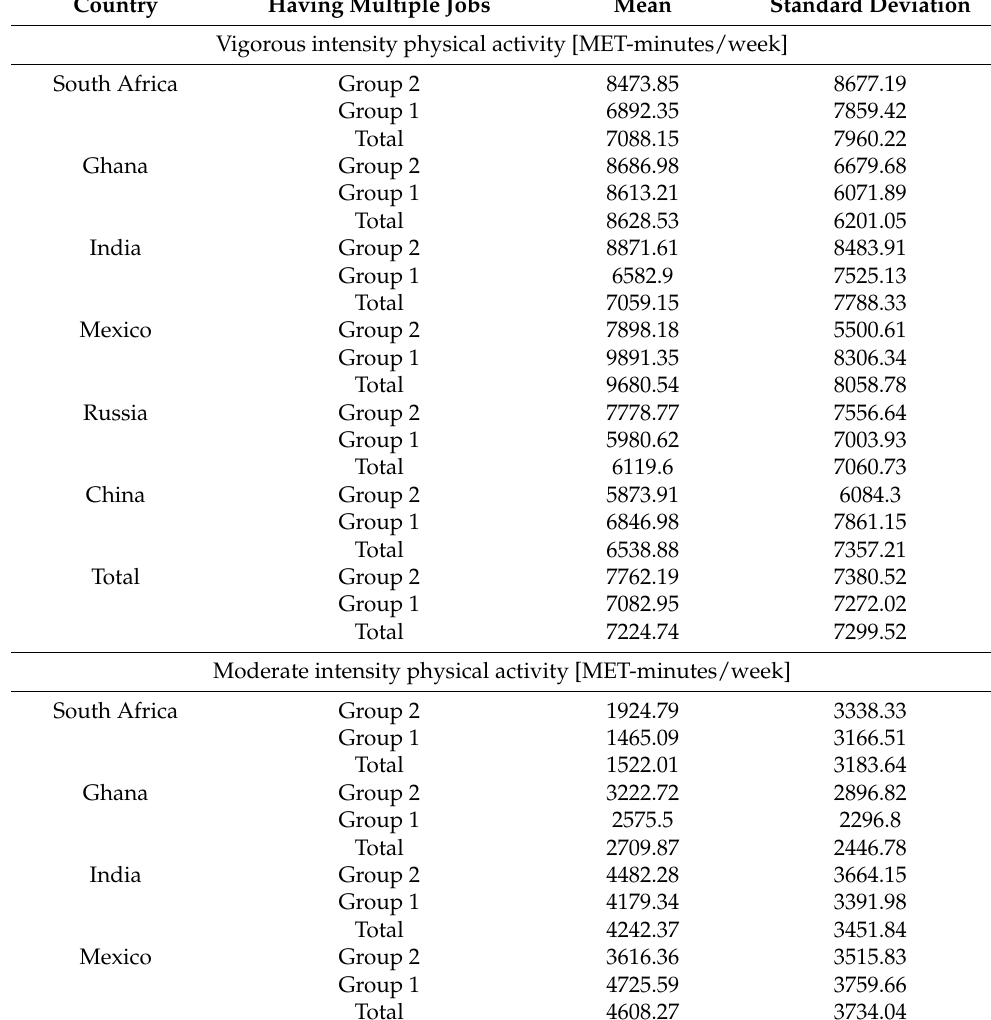
Table 2. Physical activity by country of residence and employment status [ n = 34,114]. Country Having Multiple